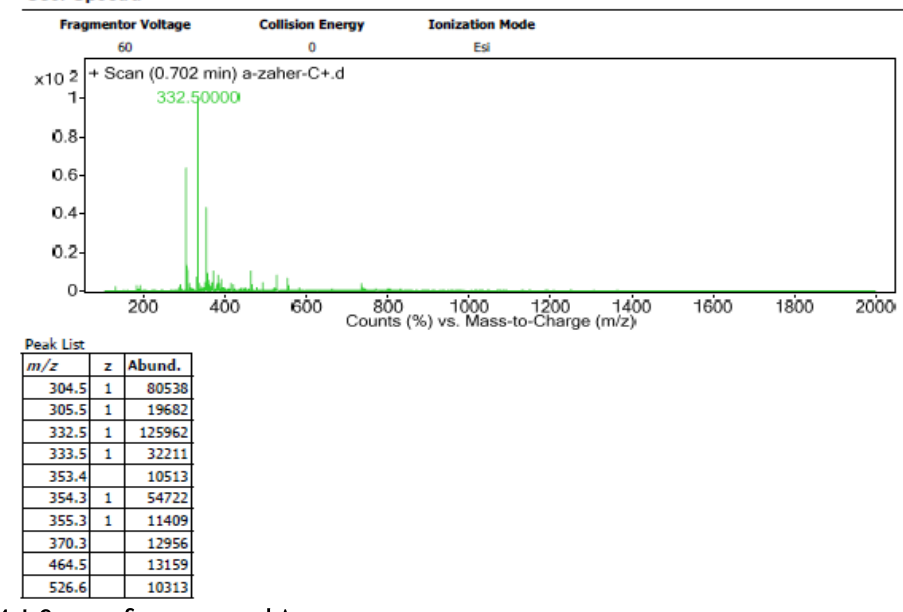
Figure 4. LC mass for compound